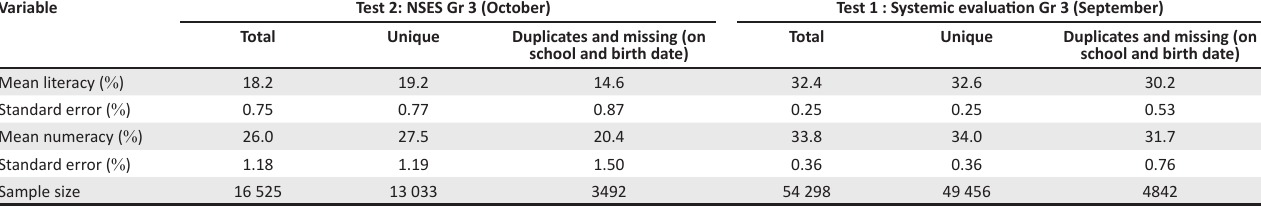
TABLE 3: Literacy and numeracy scores for grade 3 students in the Systemic Evaluation and NSES by uniquely identified individuals and duplicates. Variable